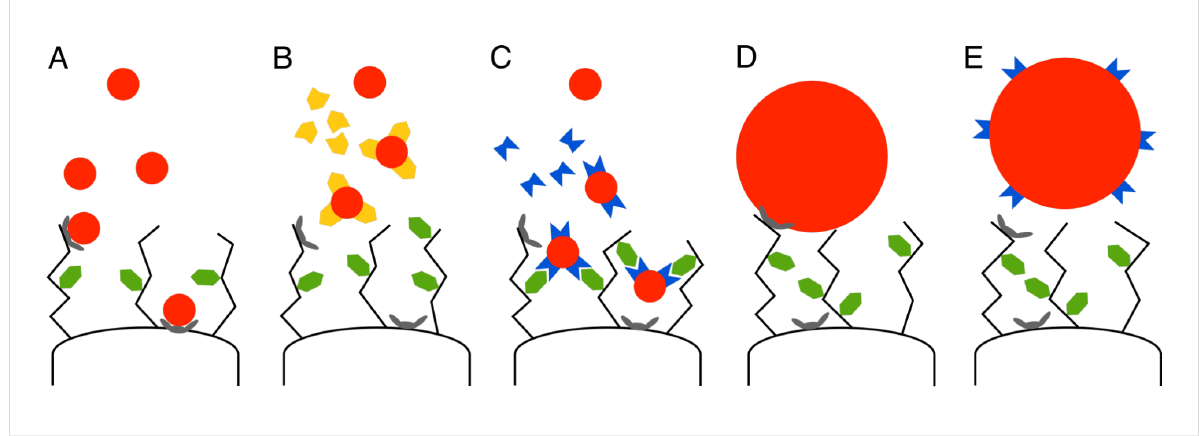
Figure 5: Schematic model of possible interaction mechanisms between differently sized NPs and endothelial cell surface. A: Non-specific binding of “naked” small NPs to outer surface structures and membrane components; B: Decreased non-specific binding of small NPs after “passivation” with proteins; C: Increased binding of small NPs pretreated with luminal gut-constituents to specific attachment sites within the glycocalyx; D: Non-specific binding of “naked” large NPs to outer surface structures of the cells; E: Abolished binding of large NPs pretreated with luminal gut-constituents since particles are too large to penetrate the glycocalyx and reach specific attachment